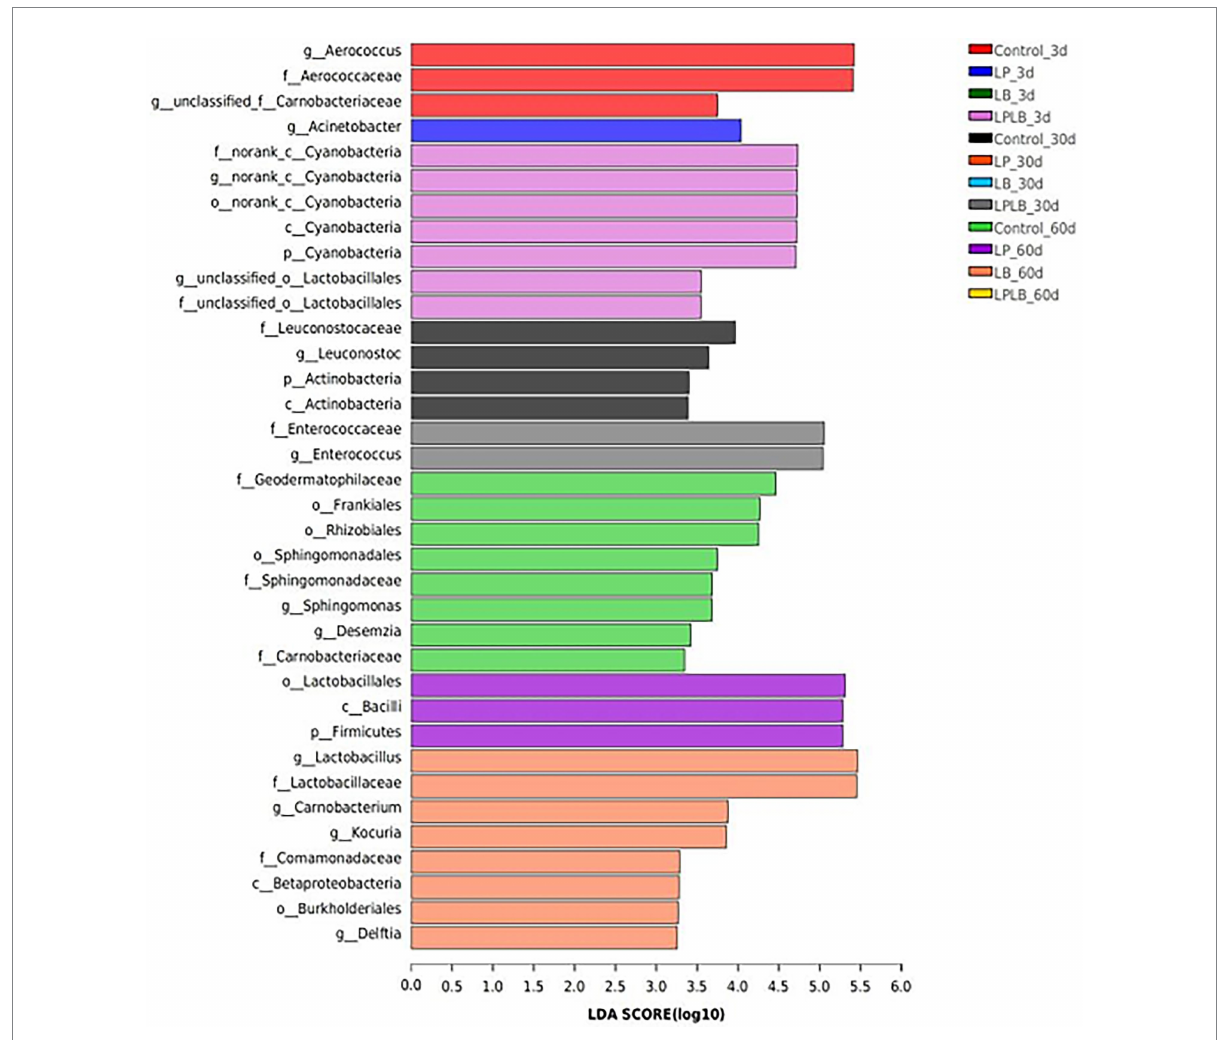
FIGURE 4 Comparison of microbial variations using LefSe analysis of paper mulberry silage. Control, ensiling with no inoculant applied; LP, inoculated with Lactiplantibacillus plantarum ; LB, inoculated with Lactiplantibacillus brevis ; LPLB, inoculated with L. plantarum and L. brevis